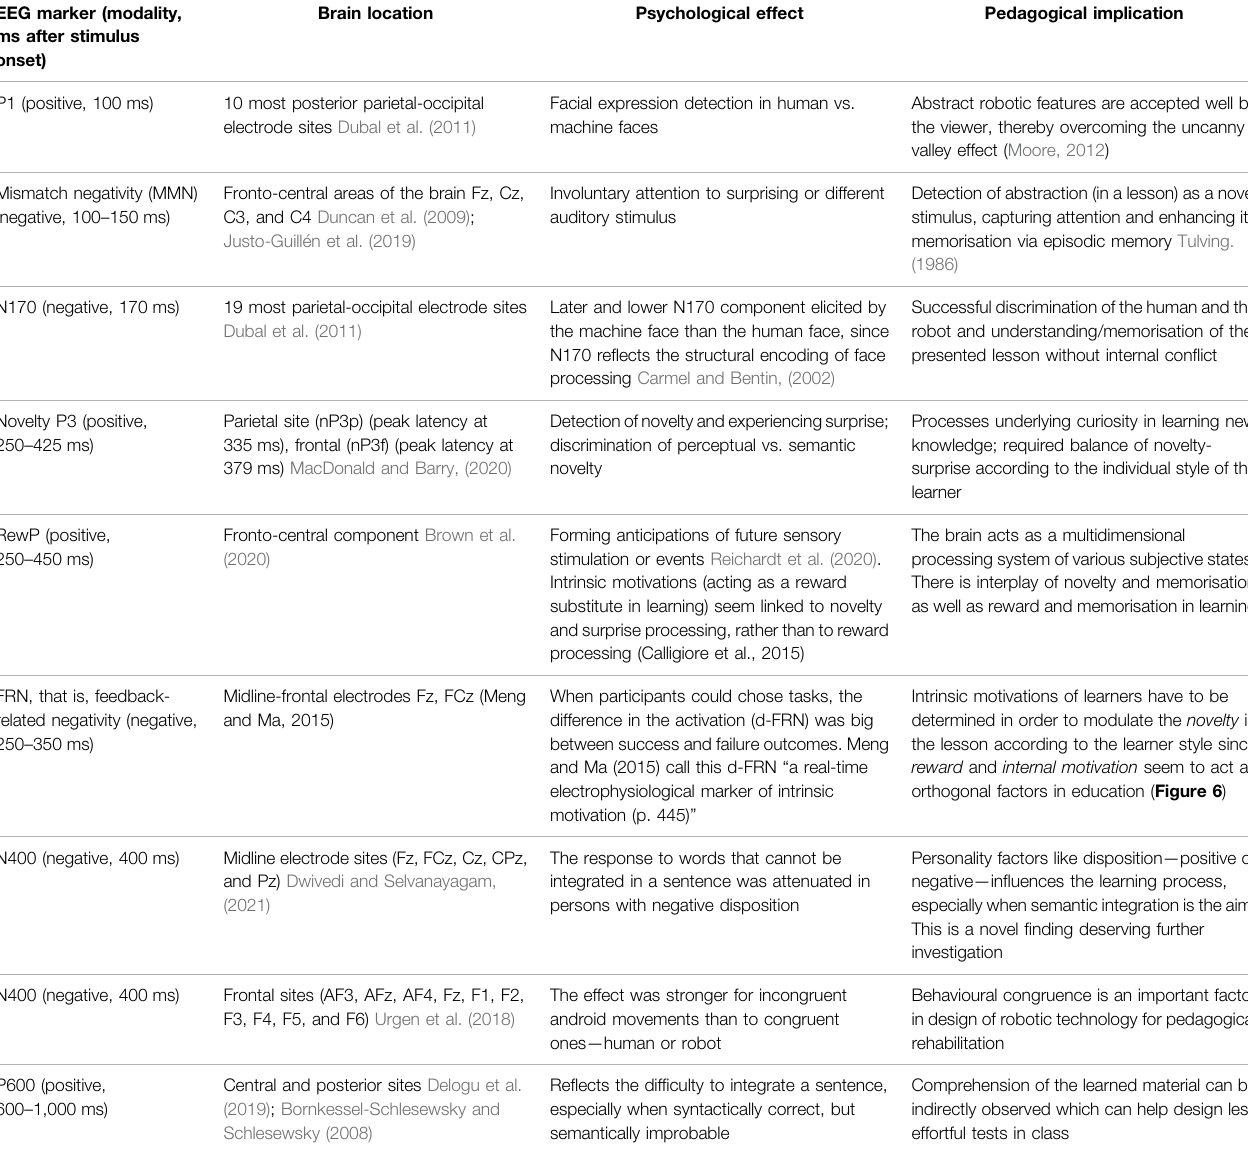
TABLE 1 | Summarisation of the EEG markers of abstraction, attention, and memory in the present survey. EEG marker (modality, ms after